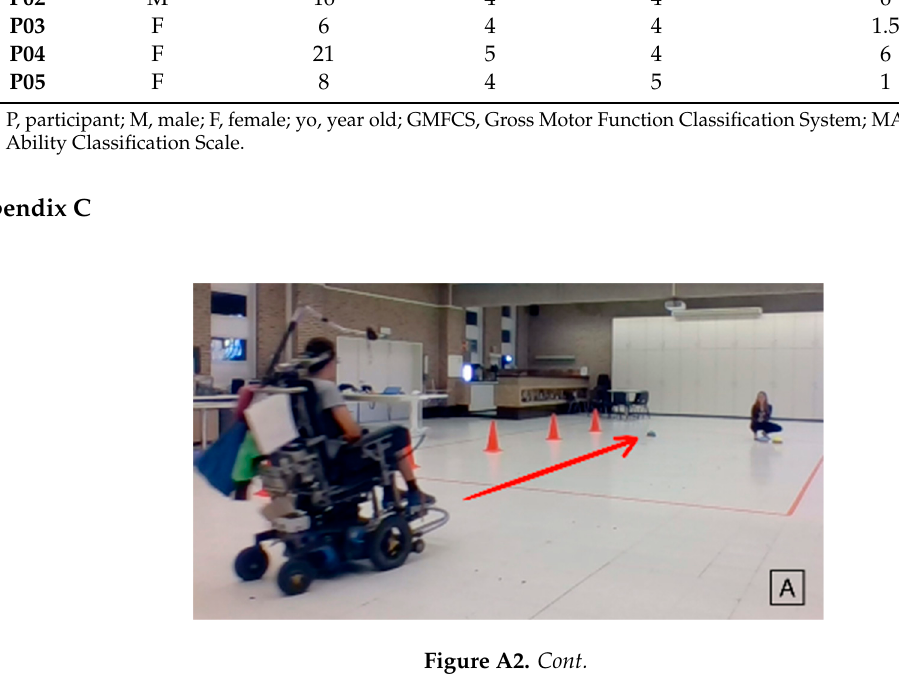
Table A1. Participants’ characteristics. Table 1. Participants’ characteristics.